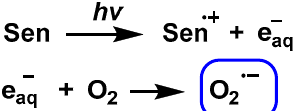
Figure 22. UV photolysis of H 2 O 2 forms HO 2• .